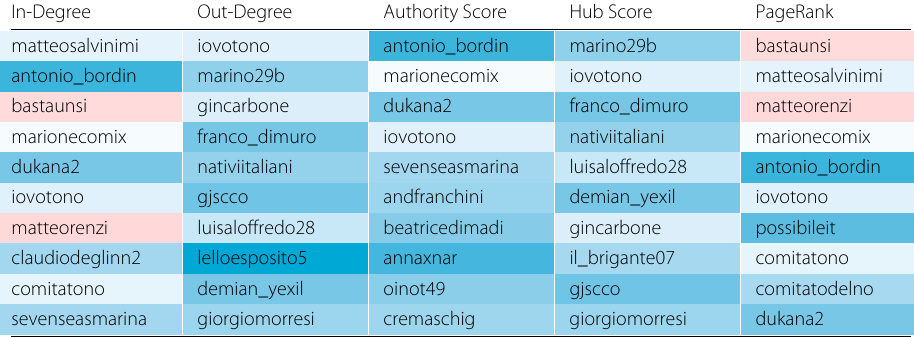
Table 1 Whole retweet graph: top 10 accounts by centrality In-Degree Out-Degree Authority Score